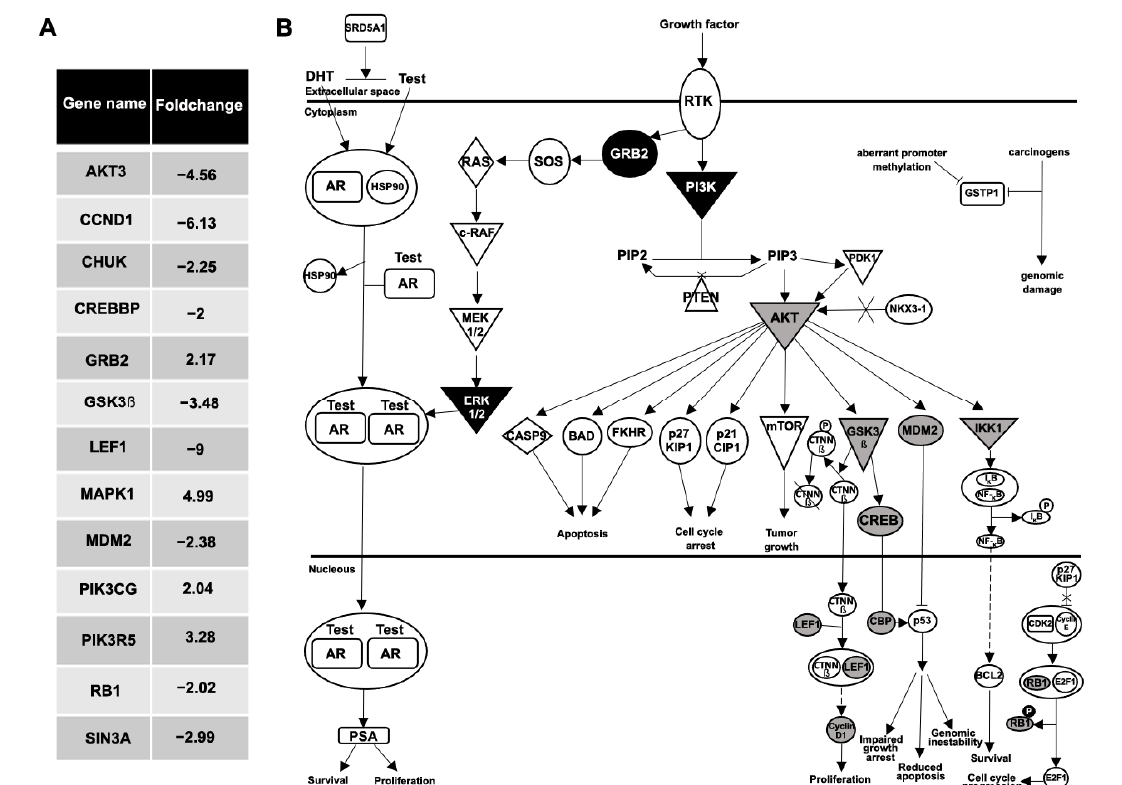
Figure 6. Analysis of prostate cancer pathway. ( A ) Fold change values of 13 differentially expressed genes in prostate cancer pathway between the plasma EVs from the BPH and the mPC samples. ( B ) Ingenuity pathway analysis network of prostate cancer signaling: nine genes were downregulated (AKT3, CCND1, CHUK, CREBBP, GSK3 β , LEF1, MDM2, RB1 and SIN3A; represented in gray color), and four genes were upregulated (GRB2, MAPK1, PIK3CG, PIK3R5; represented in black color), in EV-mRNA from mPC plasma sample compared to EV-mRNA from BPH plasma sample.